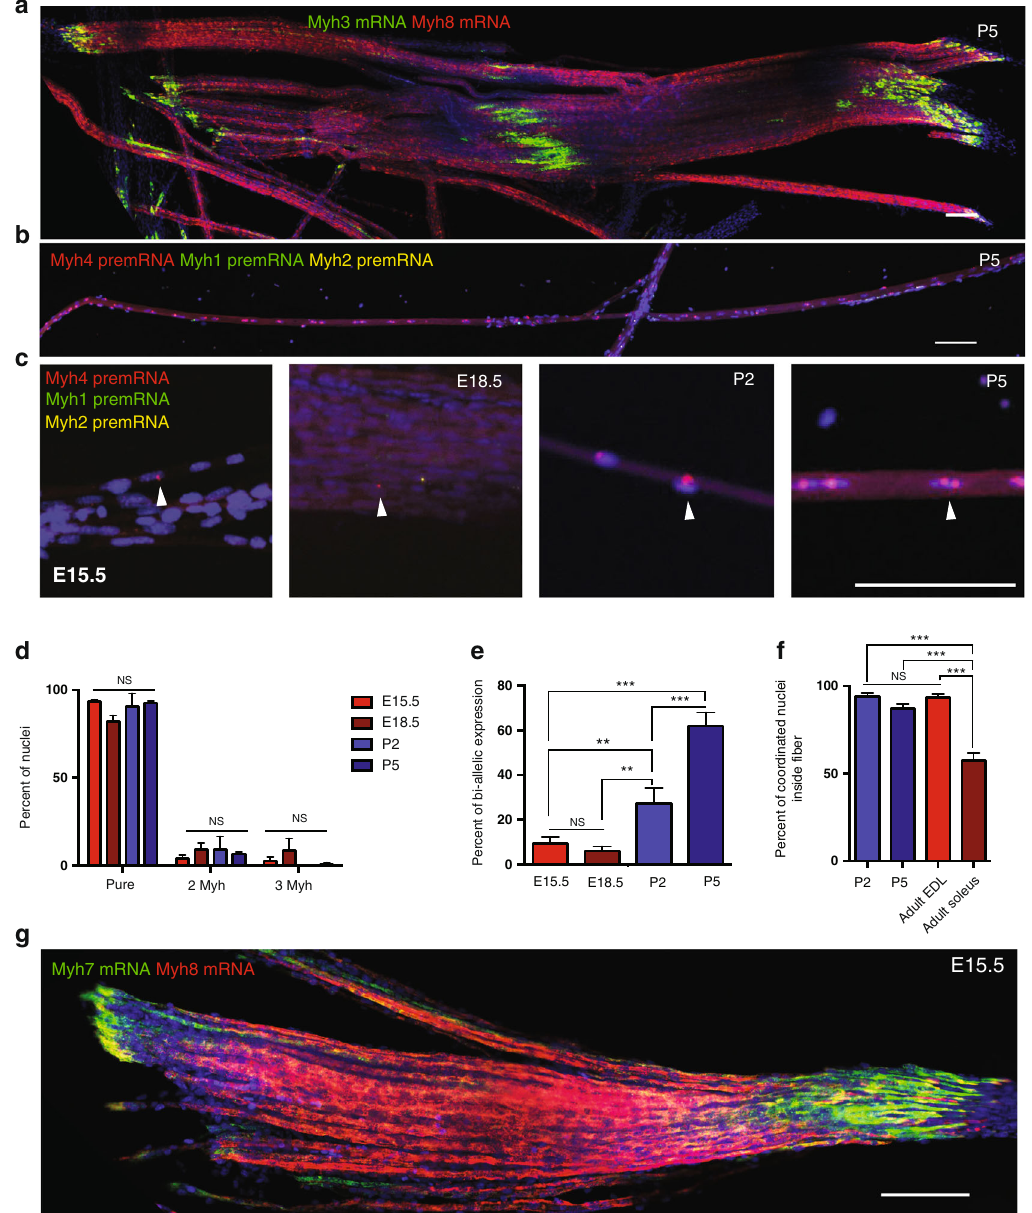
Fig. 7 f Myh expression during development is regionalized. a RNAscope against Myh3 (green) and Myh8 (red) mRNA on isolated fi bers from forelimbs at 5 days post-natal (P5). The MTJ and NMJ areas showed an accumulation of Myh3 mRNA. b RNAscope against Myh4 (red), Myh1 (green), and Myh2 (yellow) pre-mRNAs on isolated fi bers at E15.5, E18.5, 2 (P2), and 5 (P5) days post-natal. c Same as b . Zoom showing the increase of adult fast Myh - positive (arrowhead) nuclei after birth. d Percentage of nuclei expressing one, two, or three adult f Myh isoforms at the same time at different developmental stages. e Percentage of nuclei with bi-allelic expression of Myh genes during development. f Percentage of coordinated nuclei inside myo fi bers at different developmental stages. g RNAscope against Myh7 (green) and Myh8 (red) mRNAs on isolated fi bers at E15.5. Myh7 mRNAs accumulate in MTJ areas of all myo fi bers at E15.5. For ( a – c , g ) scale bar: 100 μ m. For d , n = 3 and 50 nuclei per animal. For e , f n = 3 and 20 fi bers per animal. Numerical data are presented as mean ± s.e.m. * P < 0.05, ** P < 0.01, *** P < 0.001. For a and g representative RNAscope experiments are presented, N = 3. Source data for d – f are provided in the Source Data fi